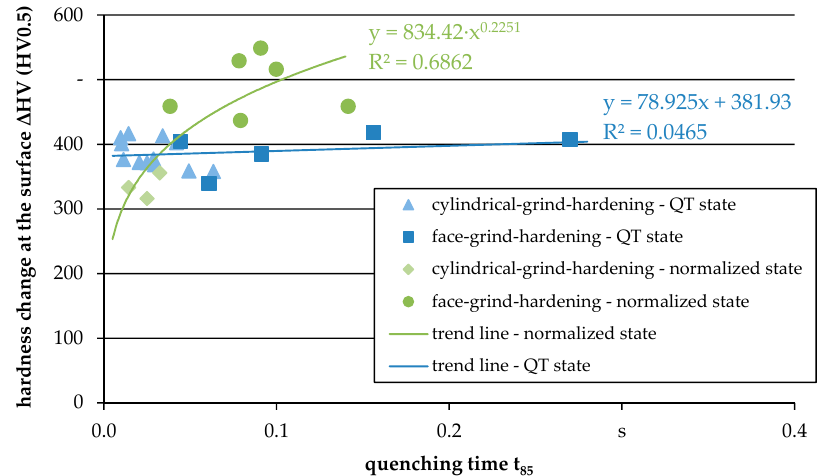
Figure 7. The hardness change at the surface Δ HV as a function of the quenching time t 85 .